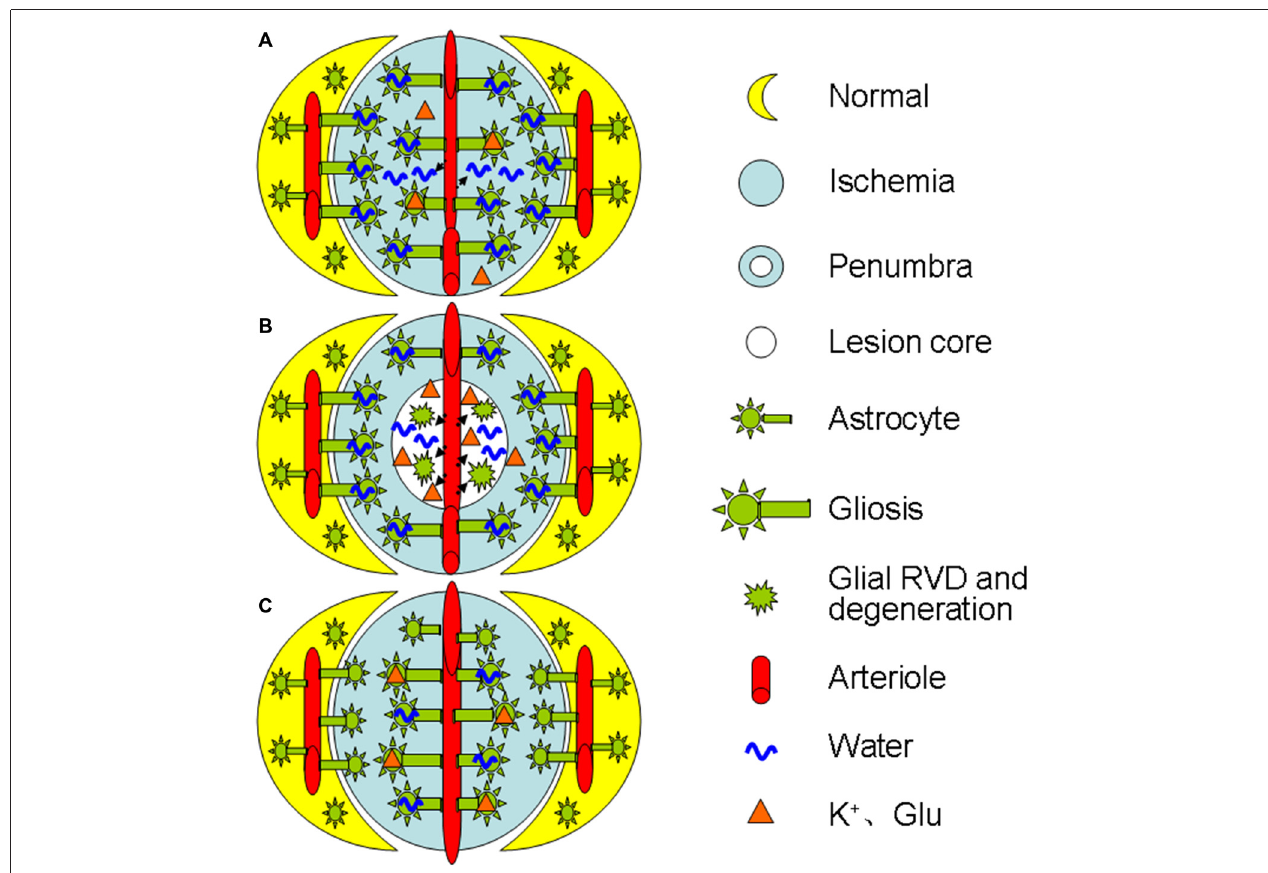
FIGURE 1 | Diagrammatic drawing of the spatiotemporal features of astrocytic plasticity in ischemic stroke (A–C). Spatiotemporal features of astrocytic involvement in ischemic stroke in the early stage (0–24 h) of a mild stroke (A) , middle stage ( > 24–72 h, B ) and the late stage (C) , respectively. The abbreviations are, Glu, glutamate; RVD, regulatory volume